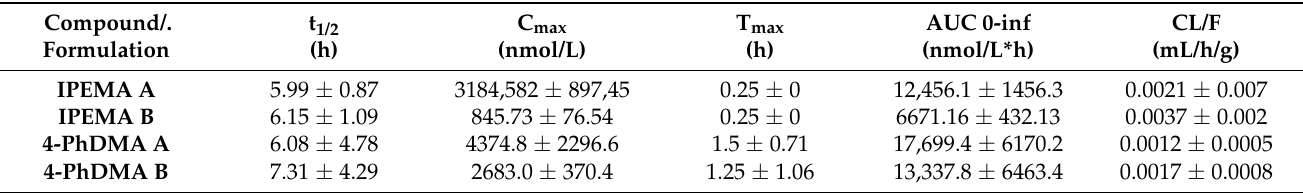
Table 6. Main PK parameters of the selected compounds formulated in SEDDS.